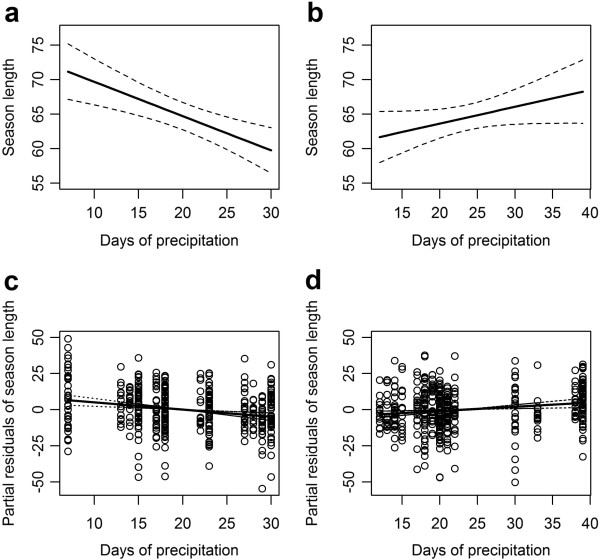
Association between season length and days of precipitation. Panels a-b show model predictions; panels c-d show partial residuals. The first column (a,c) shows the association with days of precipitation during the early period (DAY_PREC2–13) while the second column (b,d) shows the association with precipitation in the late period (DAY_PREC20–31).